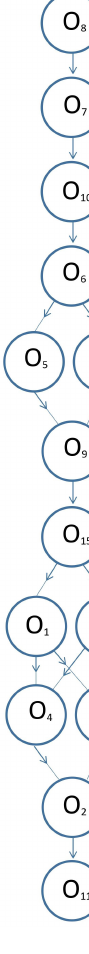
Figure 2. Nonlinear ordering Figure 2: Nonlinear ordering system